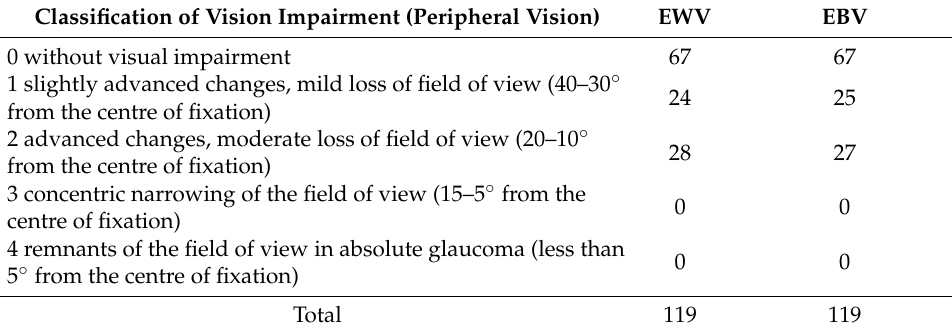
Table 3. Frequency of respondents within visual impairment (peripheral vision)